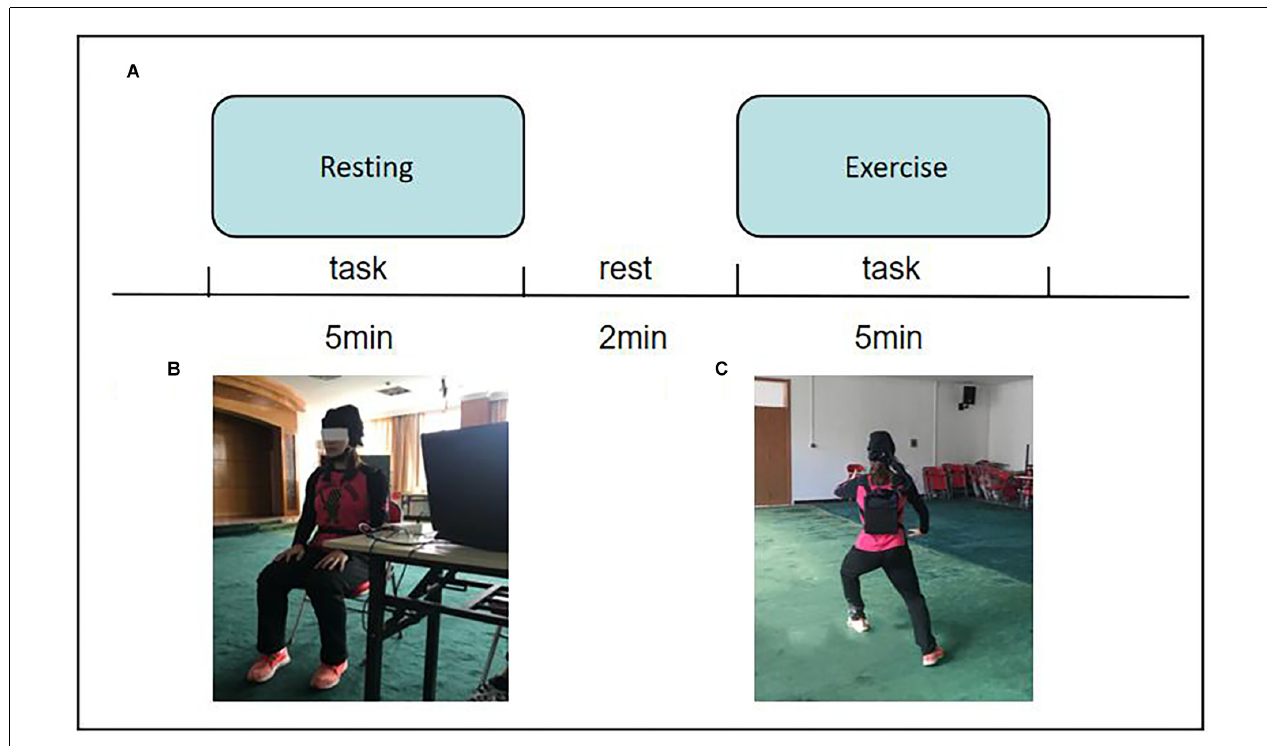
FIGURE 1 | (A) Flow chart of experiment tasks. (B) Resting state. (C) Movement